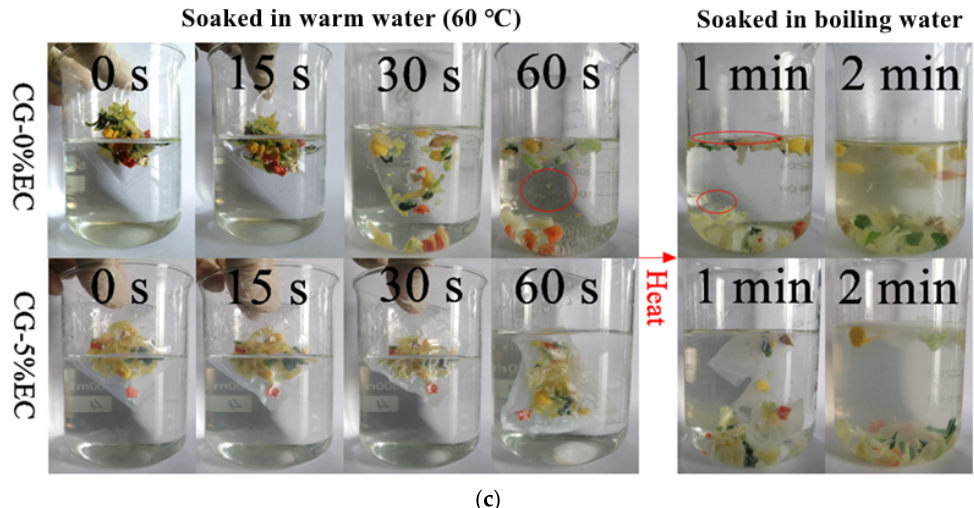
Figure 7. DR ( a ) and soaking photos ( b , c ) of films.